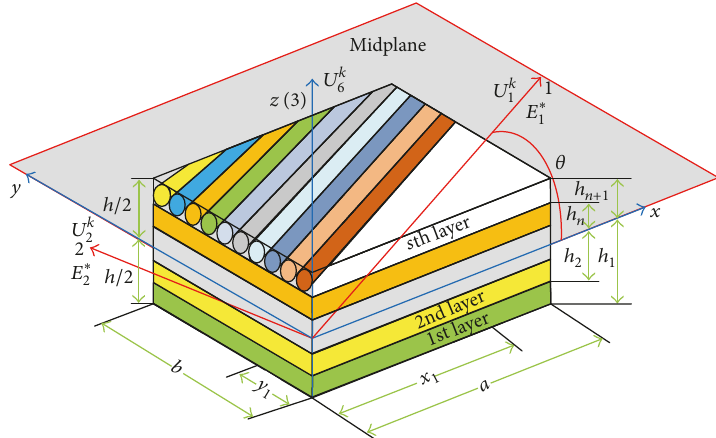
Figure 1: Damping model of fiber-reinforced composite thin plate based on complex modulus